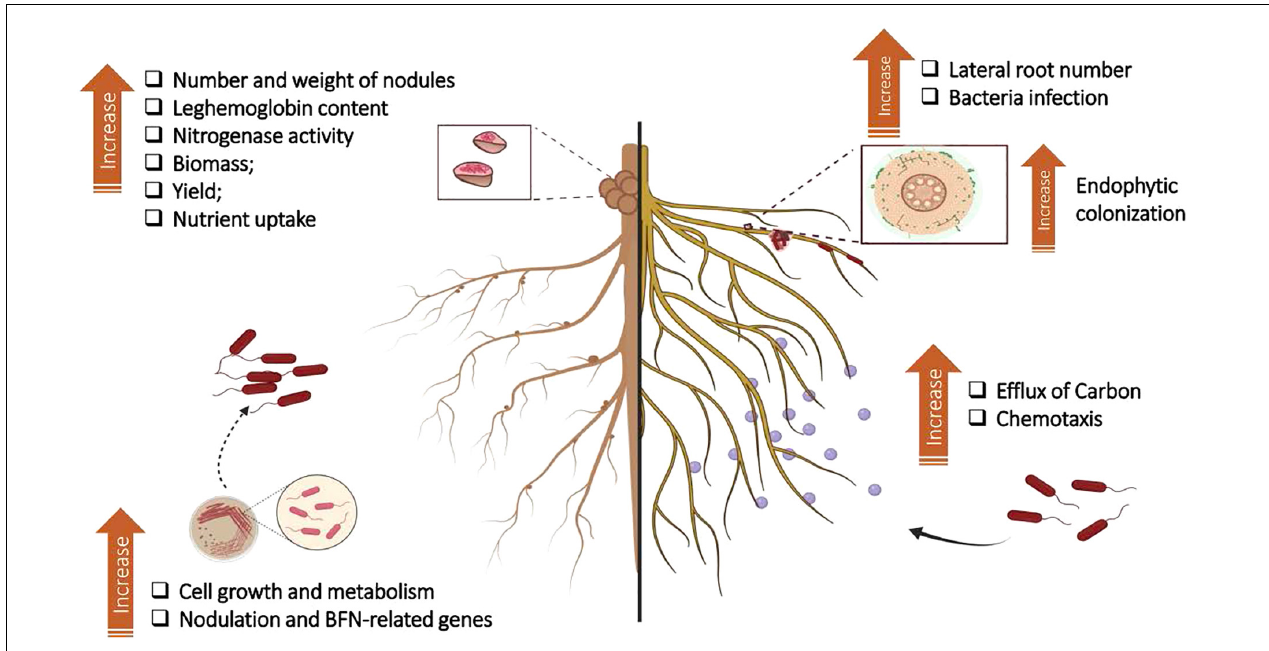
FIGURE 2 | Summary of results found in the literature on the effects of humic substances (HSs) on plant growth-promoting bacteria (PGBP) and interaction with plant root systems. The application of HSs to culture medium affects the growth and bacterial metabolism of rhizobia and induces the expression of genes related to nodulation and nitrogen fixation processes. Experiments in a greenhouse revealed that the application of HSs + rhizobia to legumes provided an increase in the number and weight of nodules, N levels, nitrogenase activity, and leghemoglobin contents. In nonleguminous plants, the combination of HSs + PGPB has been linked to increased endophytic colonization. The increase in root branching due to HSs provides more infection points for bacterial entry and, therefore, for colonization of plant tissue. The increase in carbon efflux through the roots stimulates microbial chemotaxis from the soil to the rhizosphere. Adapted from Olivares et al. (2017). Figure created using BioRender